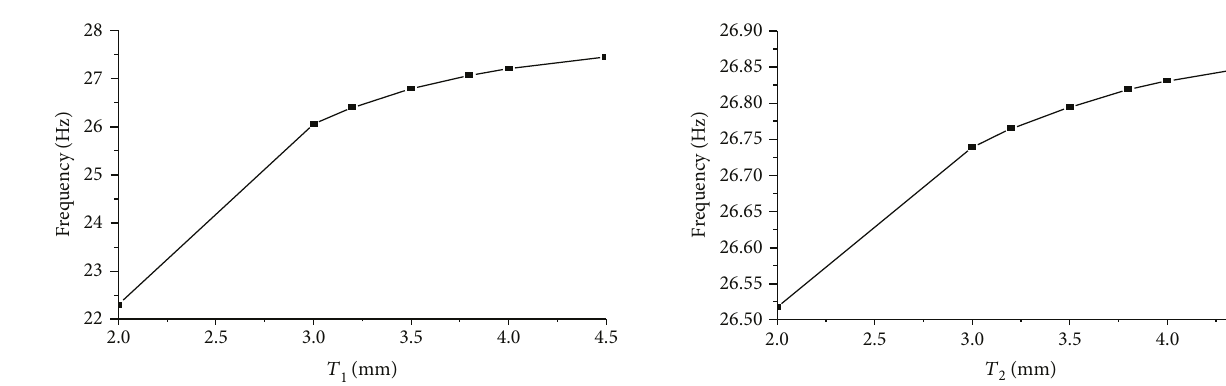
Figure 16: In fl uence of the inertial bracket rib thickness on the fi rst modal frequency of the equipment